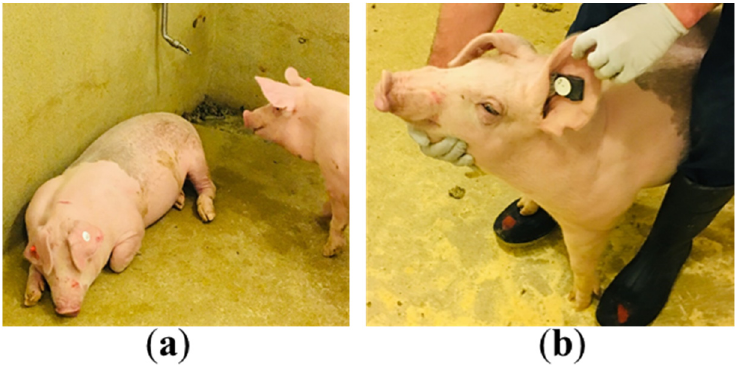
Figure 3. Animal testing: ( a ) two growing pigs were used for testing the electronic sensor boards; ( b ) the ear tag with the sandwiched electronic sensor board was attached to the left ear of the pig. The sensors and ASIC chip were remotely controlled by predefined awake/sleep cycles.